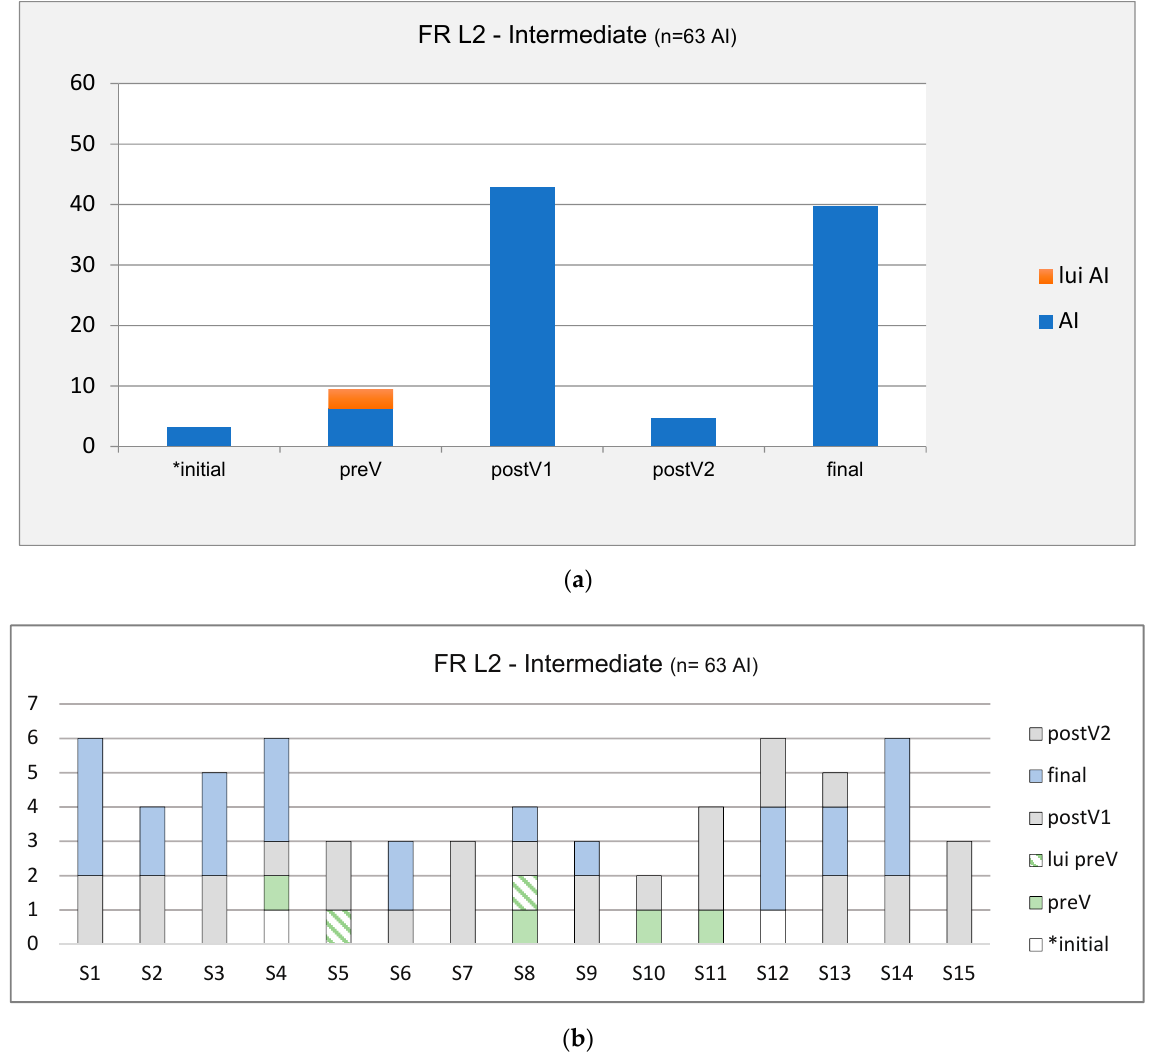
Figure 6. ( a ) Intermediate learners: group distribution of AI. ( b ) Intermediate learners: individual distribution of AI (* = agrammatical position in the TL).